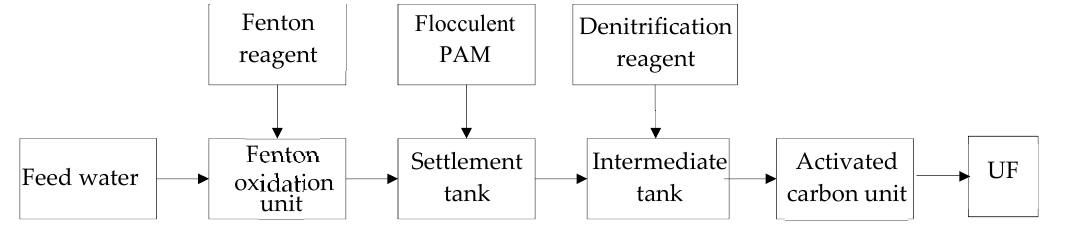
Figure 1. Treatment process. PAM: polyacrylamide; UF: ultrafiltration.